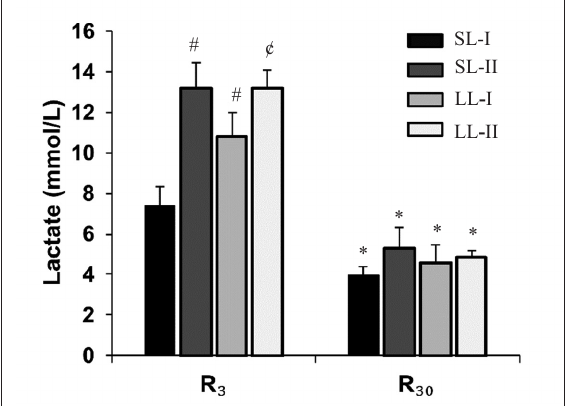
Figure 5. Lactate concentration in capillary blood results 3 min and 30 min of rest time after high-intensity physical task of sustained maximal (uni-)bilateral Note. SL-I – short length unilateral; SL-II – short length bilateral; LL - I – long length unilateral; LL - II – short length bilateral; * p < .05 with R3 mean; # p < .05, SL-I vs SL-II, LL-I vs LL-II at R3 mean; ¢ p < .05, SL-II vs LL-II at R3 mean.